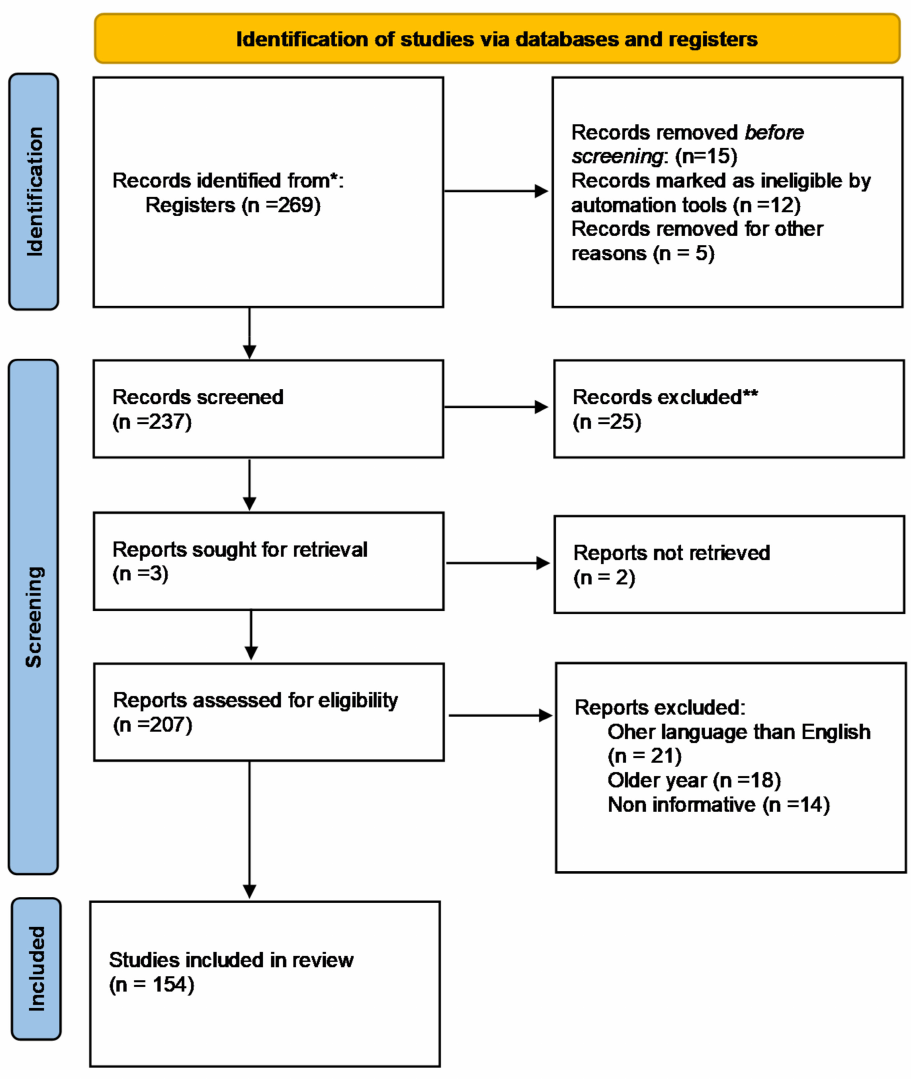
Figure 3. PRISMA flowchart describing the reference selection procedure. * PubMed, Web of Science, Cochrane Library, Google scholar, etc. ** repeated, irrelevant or duplicate